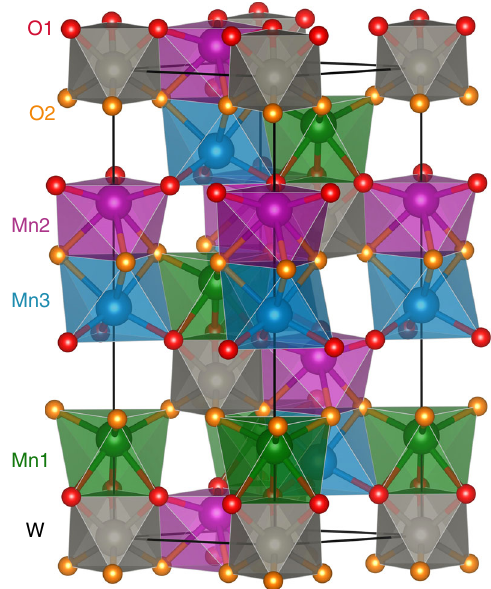
Fig. 1 Crystal structure of Mn 2 MnWO 6 . The three-dimensional framework structure of Mn 2 MnWO 6 viewed along [110] direction, to show the face- sharing Mn1O 6 -WO 6 and Mn2O 6 -Mn3O 6 octahedral pairs along the c -axis and the edge-sharing Mn1O 6 -Mn3O 6 and Mn2O 6 -WO 6 octahedral pairs in the ab -plane. The color codes of spheres are corresponding to Mn1-green, Mn2-purple, Mn3-cyan; W-light gray, O1-red, and